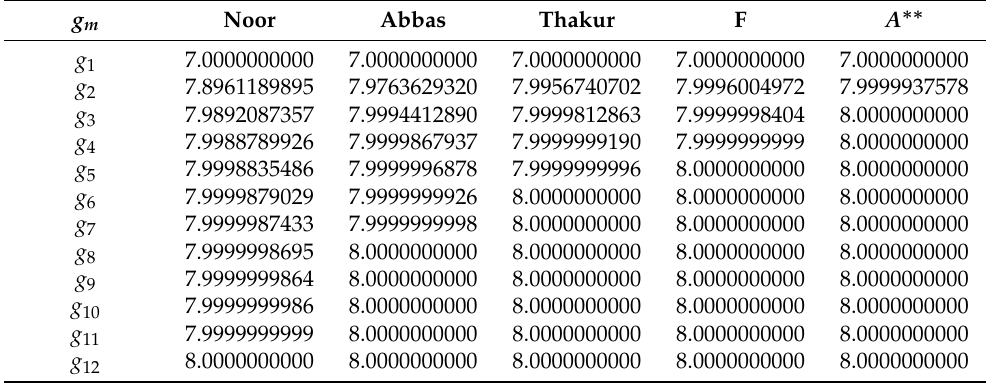
Table 2. Comparison of speed of convergence of the A ∗∗ iteration method with some known itera- tion